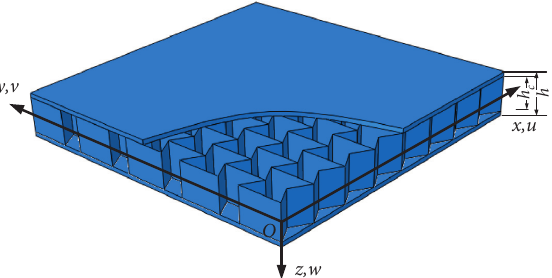
Figure 1: Geometry of the FGH sandwich